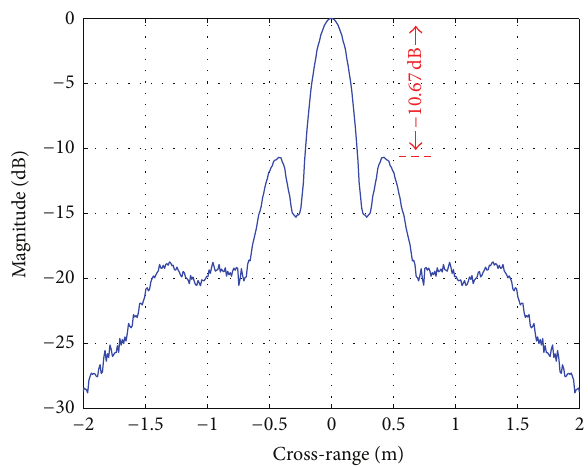
Figure 7: Support area of the spatial spectrum for this array.